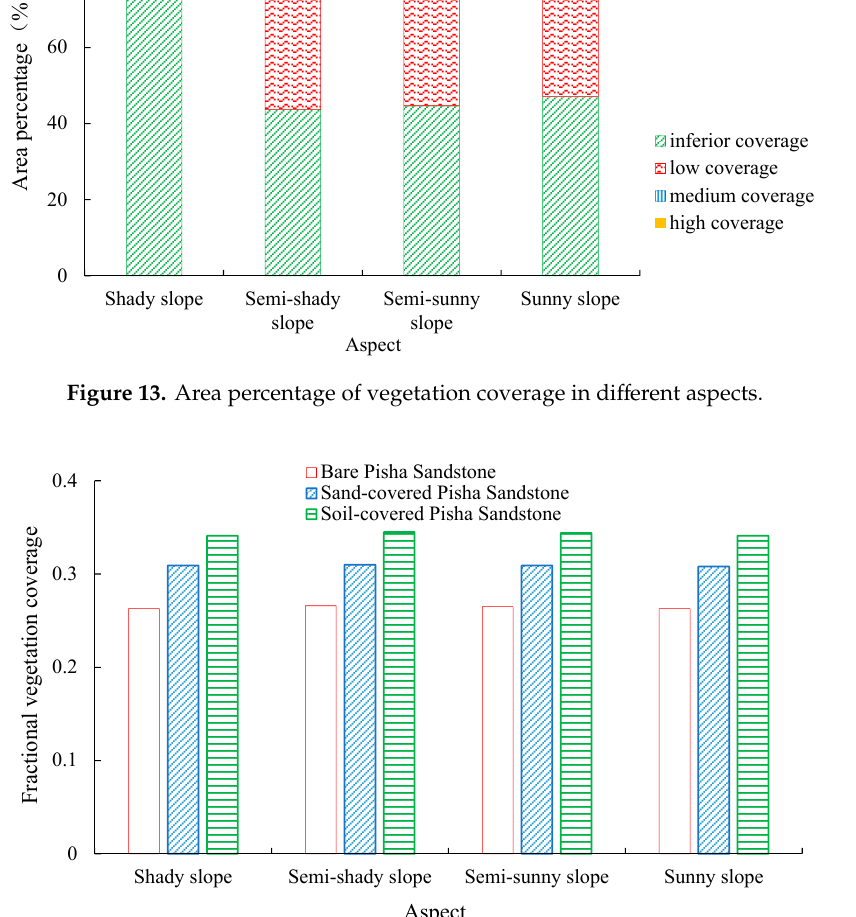
Figure 13. Area percentage of vegetation coverage in different aspects.